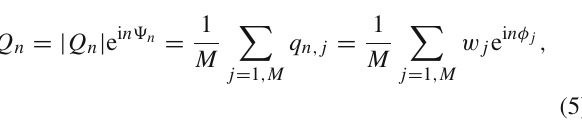
(cid:8) (cid:4) (left panel), and EP method, (cid:3) Q N P ∗ n Q n